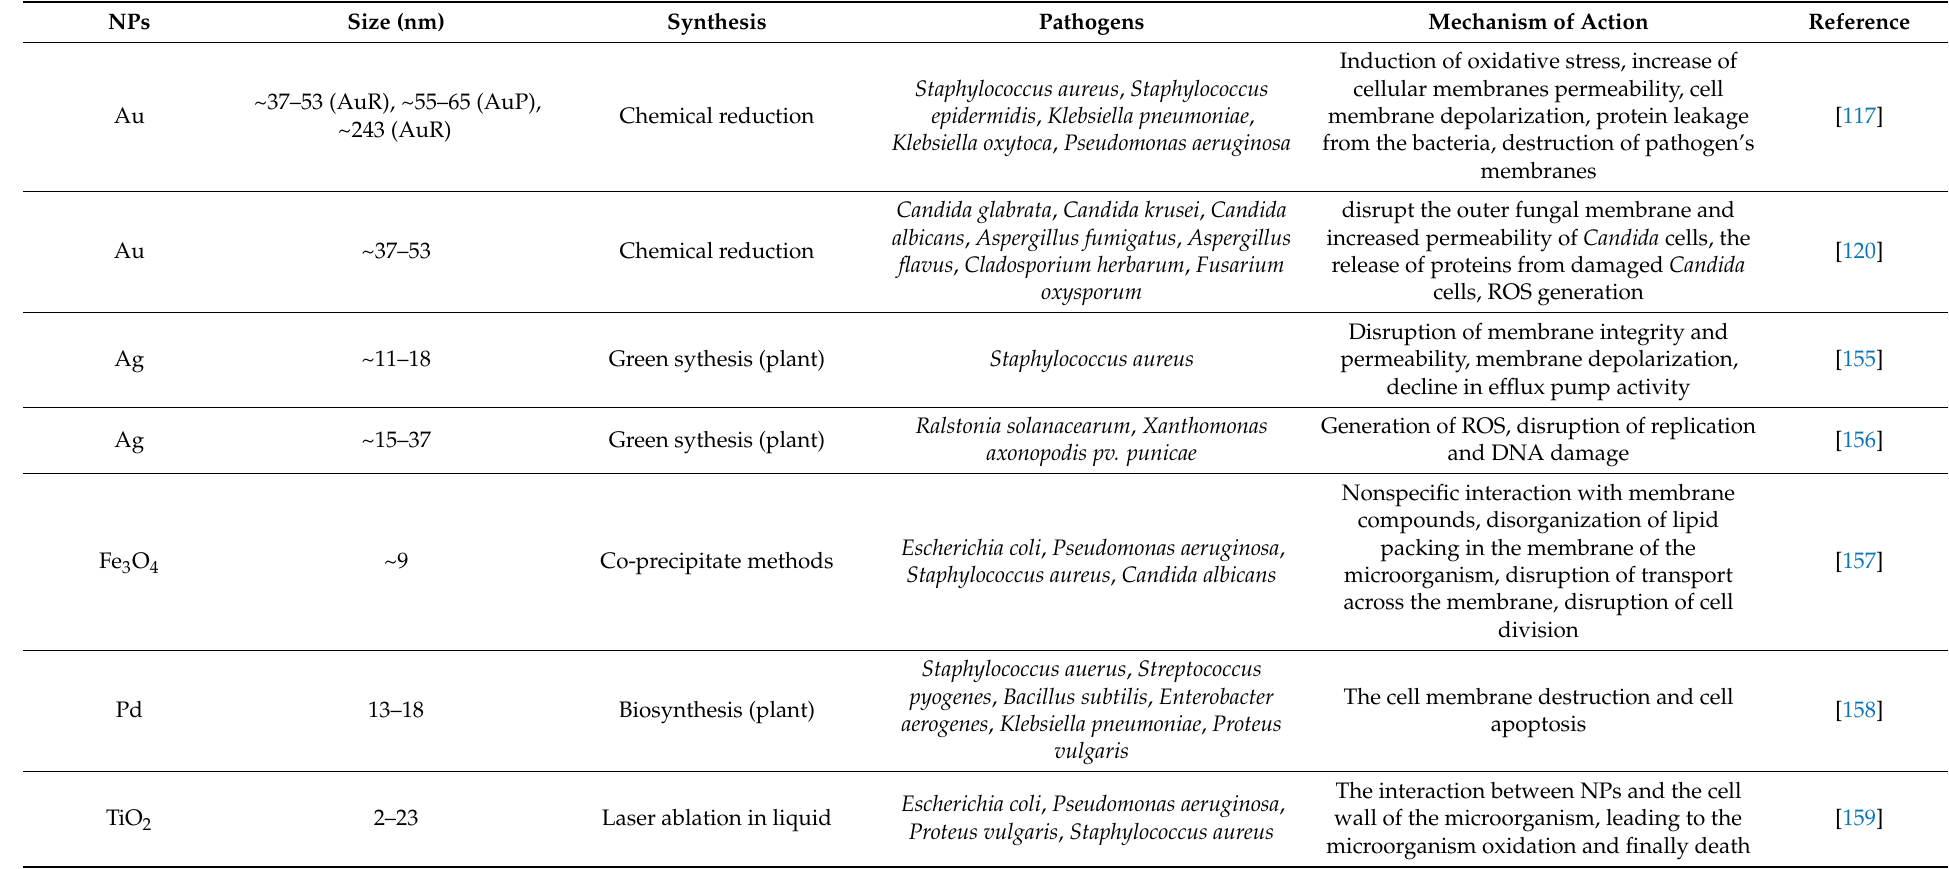
Table 1. Antimicrobial activity of monometallic NPs. Abbreviations: Au, gold; Ag, silver; Fe 3 O 4 , iron (II, III) oxide; Pd, palladium; TiO 2 , titanium dioxide; ZnO, zinc oxide; Se,